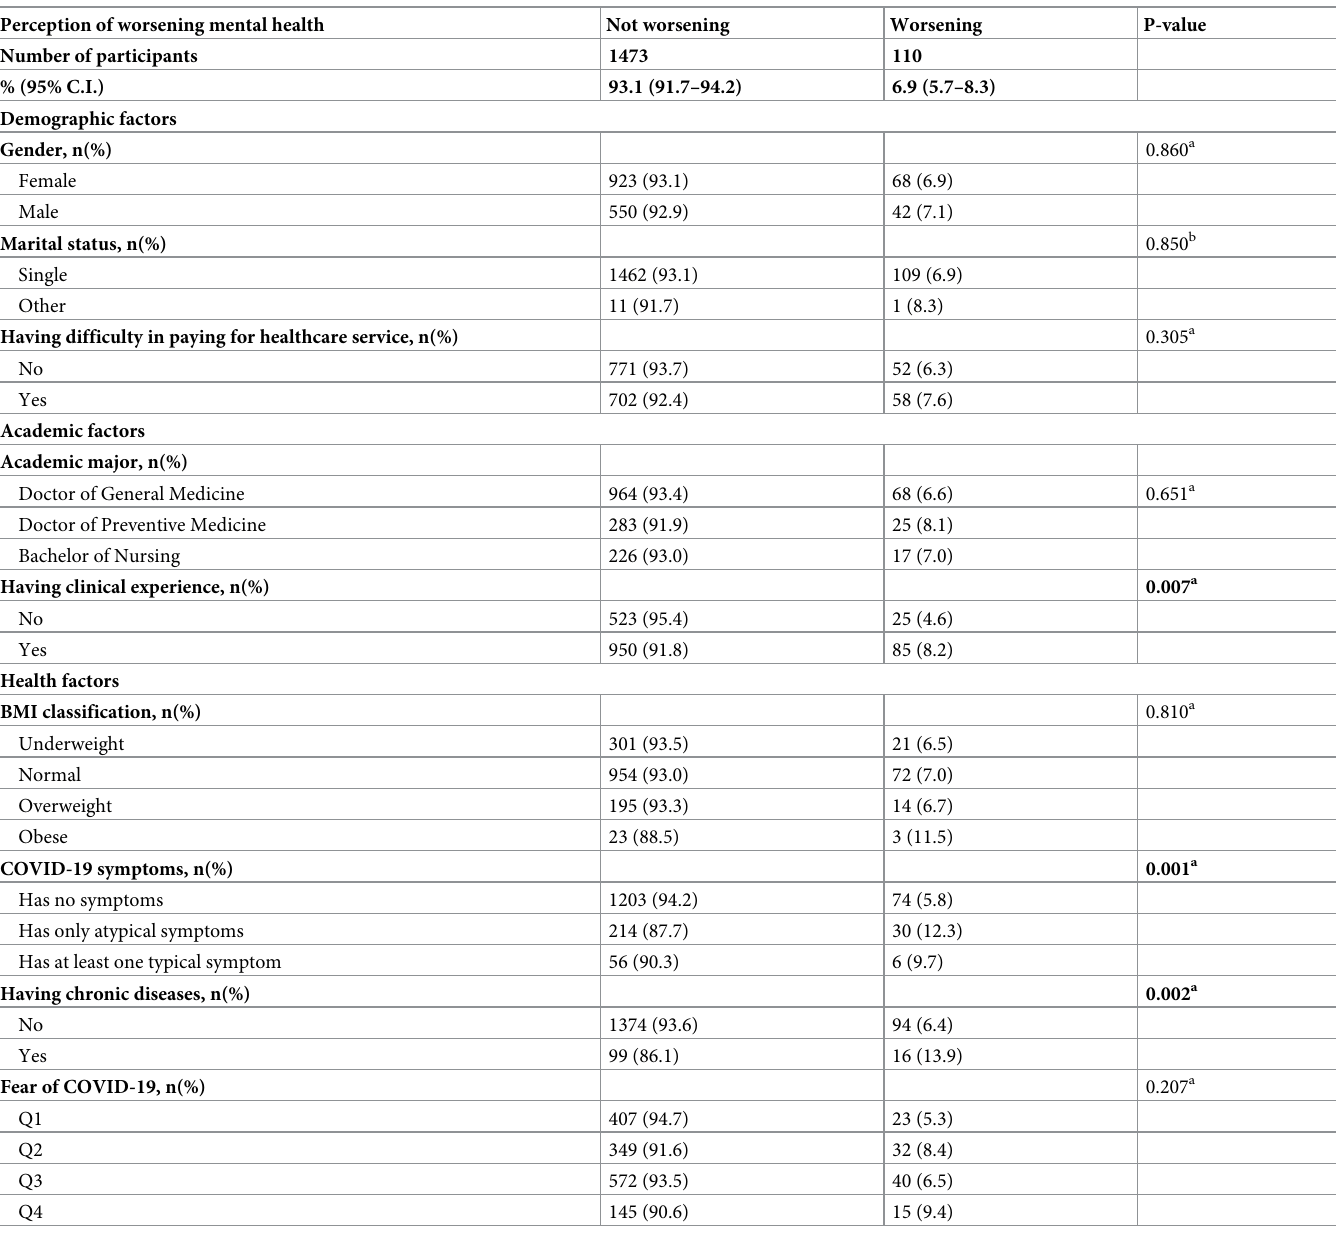
Table 4. The distribution of students having worsening mental